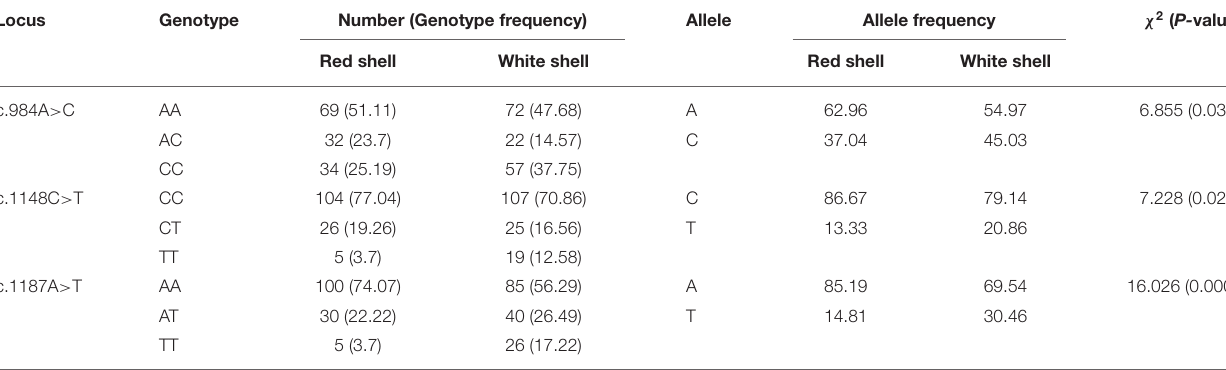
TABLE 2 | Analysis of association between the SNPs of Mm-BCDO2 and clam shell color.